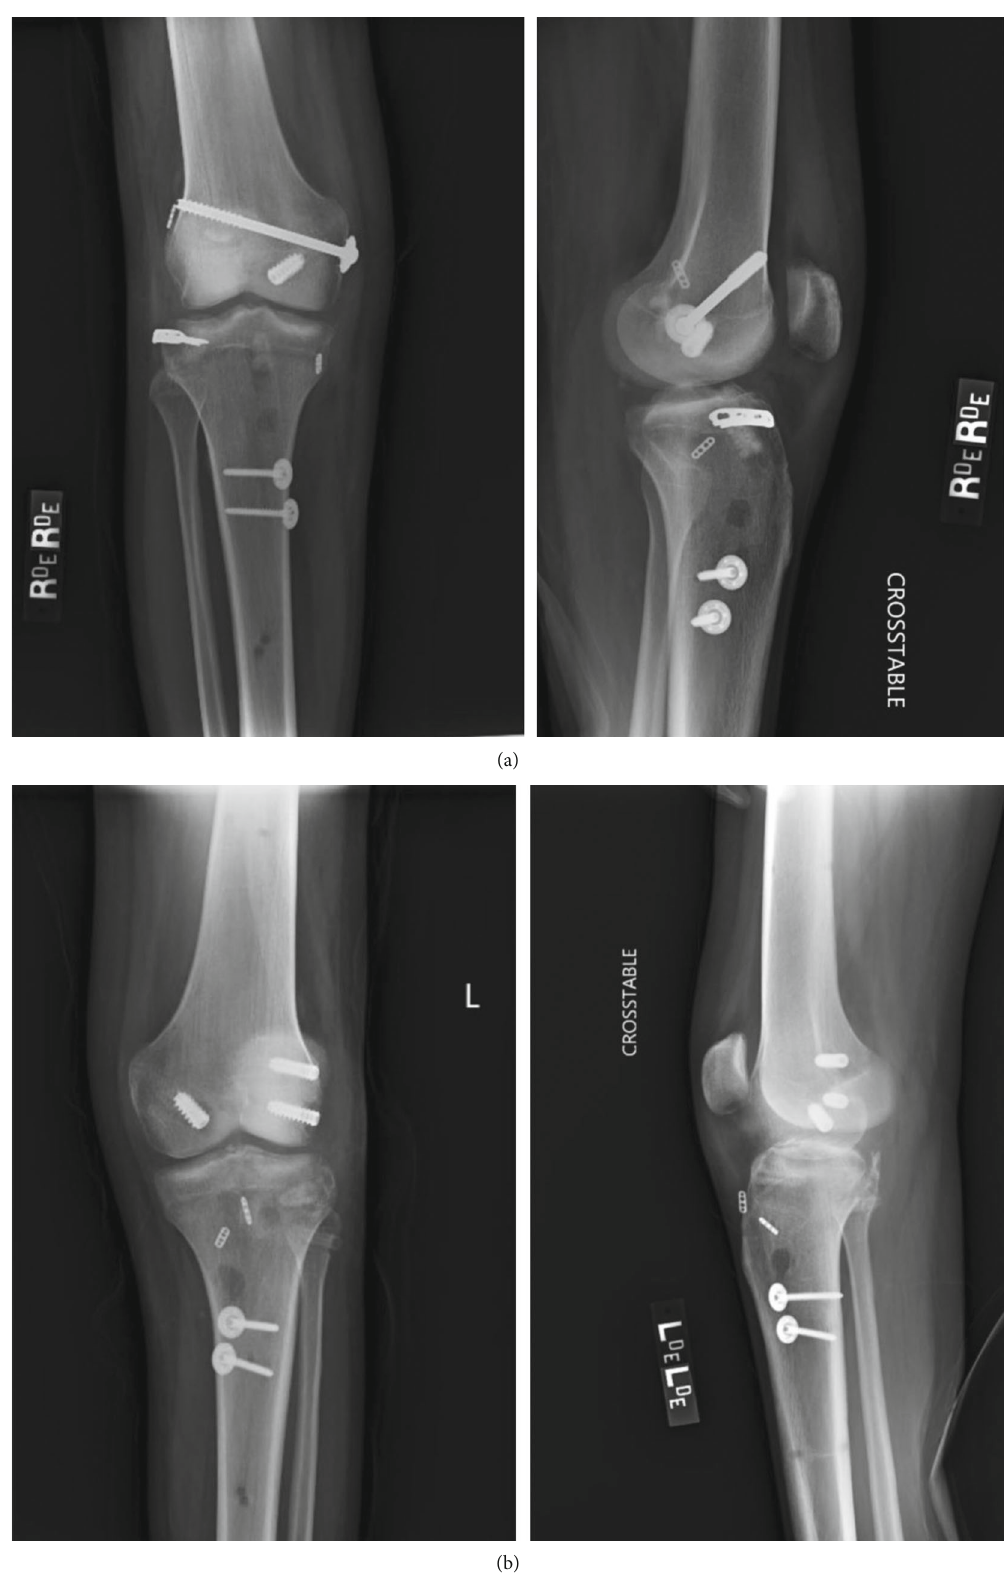
Figure 5: (a) Postoperative X-ray of the right knee. (b) Postoperative X-ray of the left